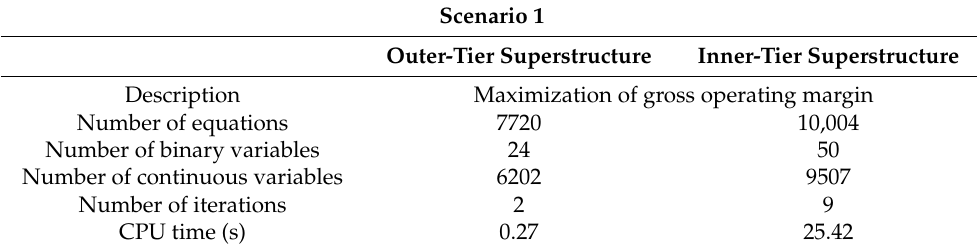
Table 2. Calculation time of the optimal biorefinery configuration of Scenario